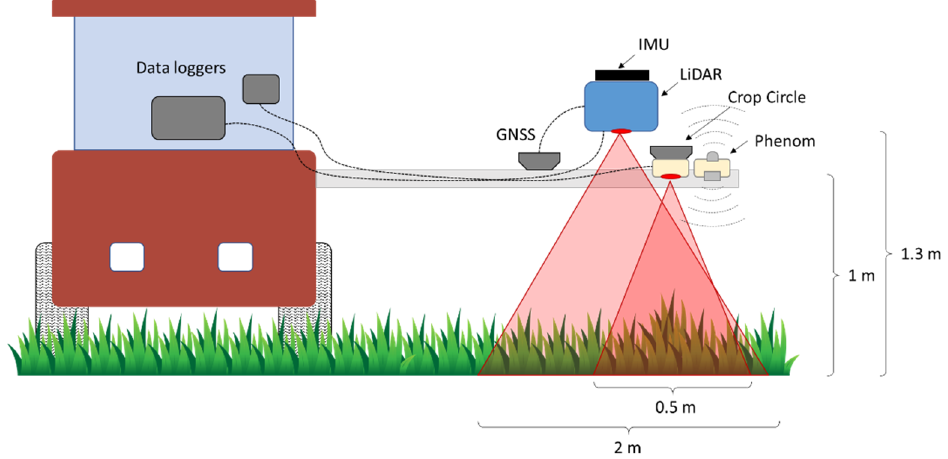
Figure 2. Schematic figure of LiDAR and reflectance sensors mounted on an all-terrain vehicle for crop scanning; figure out of scale.